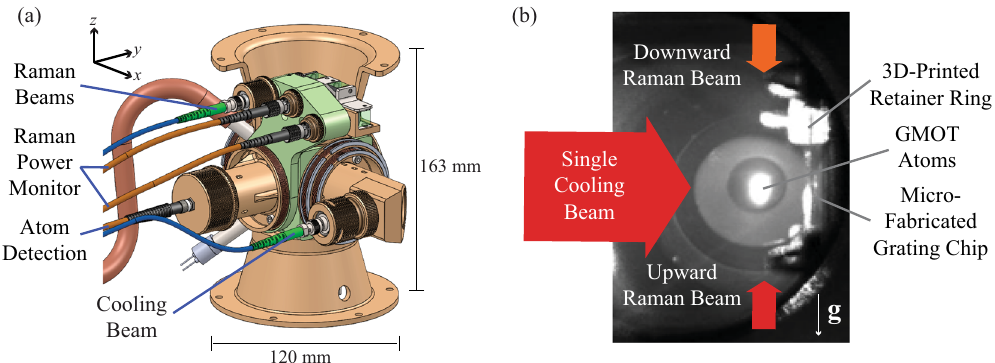
Fig. 1 Concept of the compact light-pulse atom interferometer (LPAI) for high-dynamic conditions. a 3D rendering of the compact LPAI sensor head with fi xed optical components and reliable optomechanical design. b Picture of the steady-state GMOT atoms in the